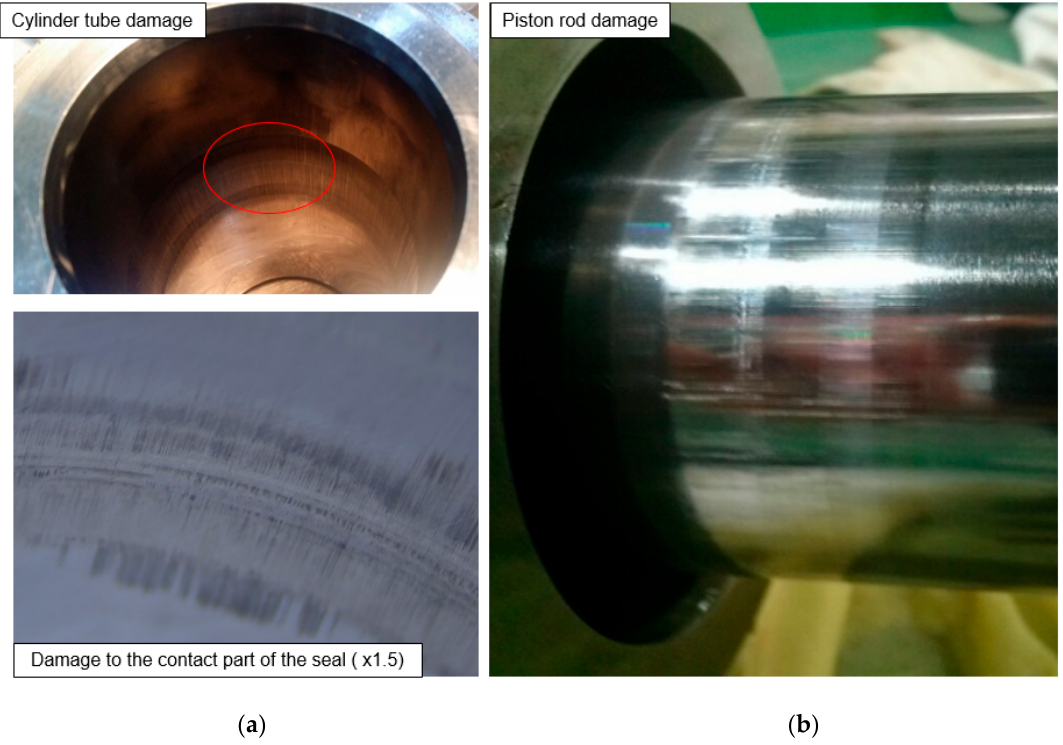
Figure 3. Fault picture of hydraulic servo actuator (a ) Tube burning ( b ) Rod burning.